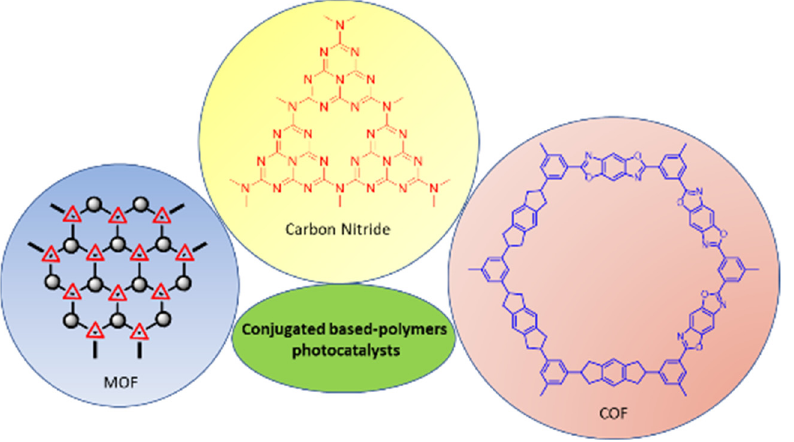
Figure 7. Examples of conjugated polymer